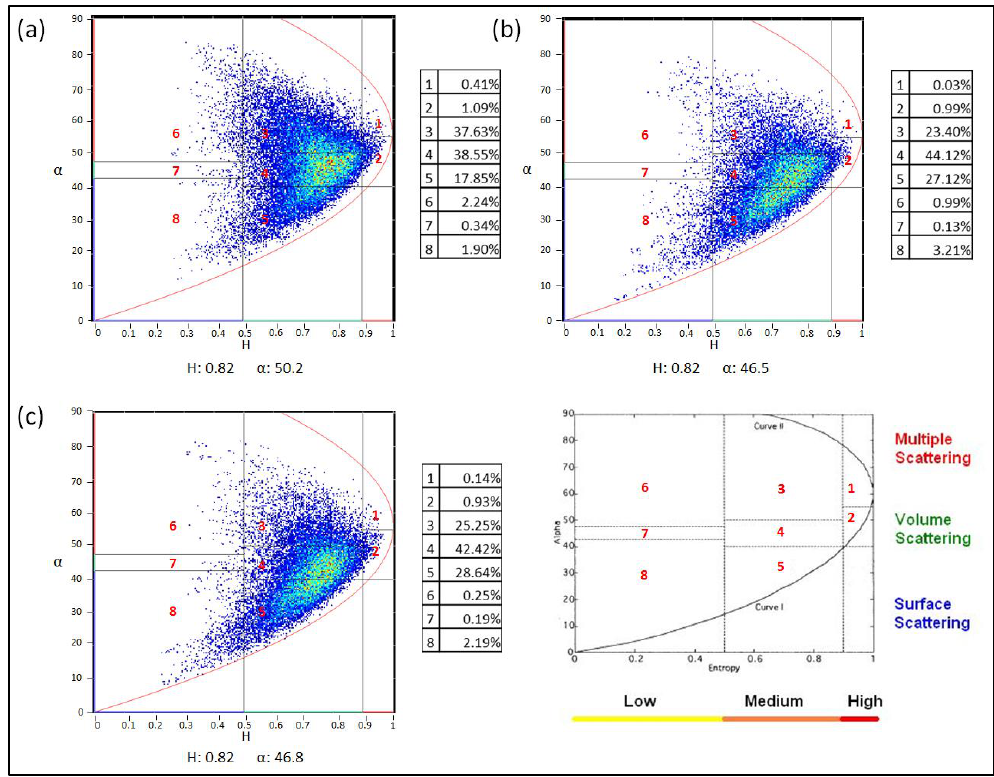
Figure 10. Urban Cloude-Pottier H/α decomposition based on RADARSAT-2 fine-quad beam modes for ( a ) 20 June; ( b ) 4 August; and ( c ) 21 September.